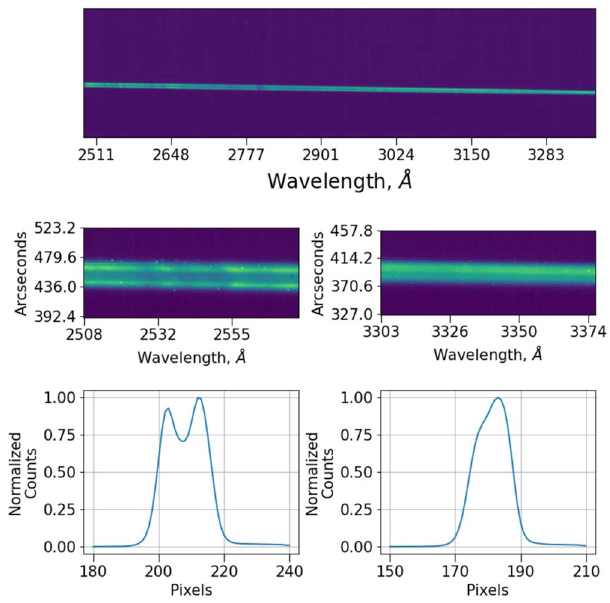
Figure 5. Top: a 2048 × 515 CUTE spectral image of Castor with background effects removed to show the spectrum. Middle left: zoom of a blue portion of the CUTE spectrum to highlight the out-of-focus lobes. Middle right: zoom of a red portion of the CUTE spectrum to highlight the less-out-of-focus lobes. Bottom: one-dimensional cross-sections of the middle panels.